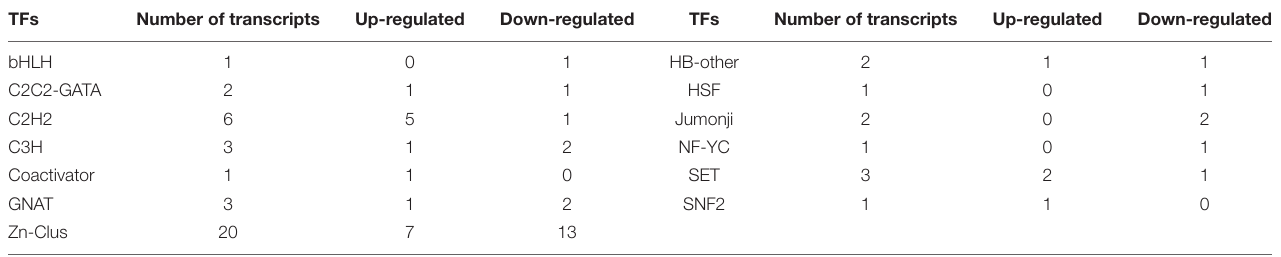
TABLE 2 | Transcription factors identified from the DEGs between the strain MD33 and UN32.